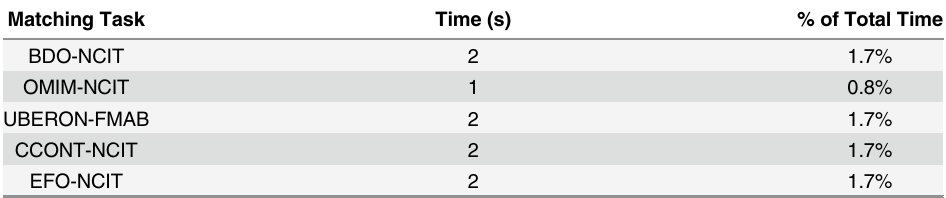
Table 7. Core fragments computation times for five Bioportal